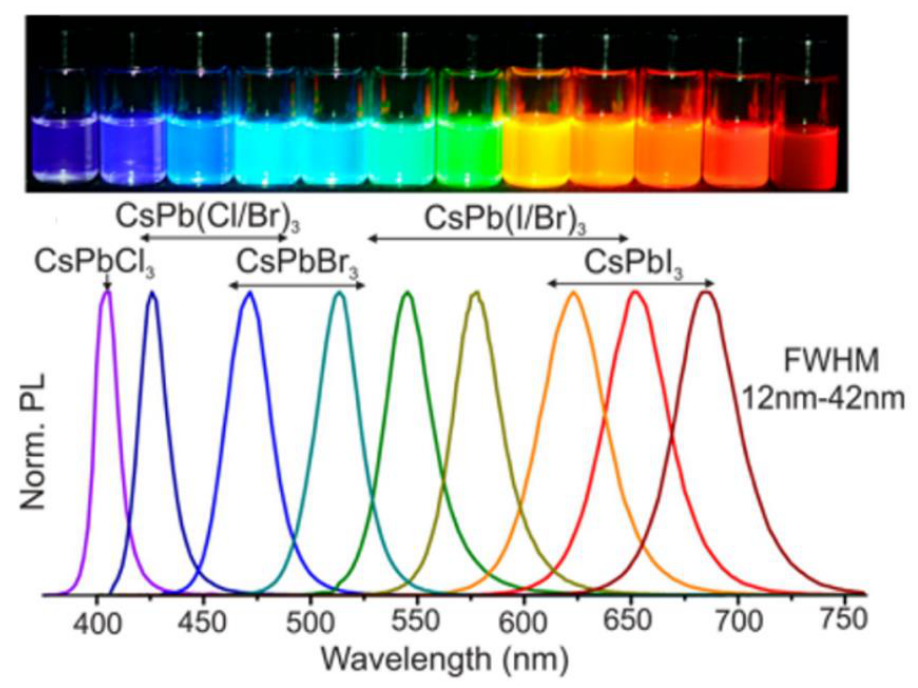
Figure 3. Colloidal perovskite changes different materials to generate different color photolumines- cence [49]. Copyright 2015 American Chemical Society.